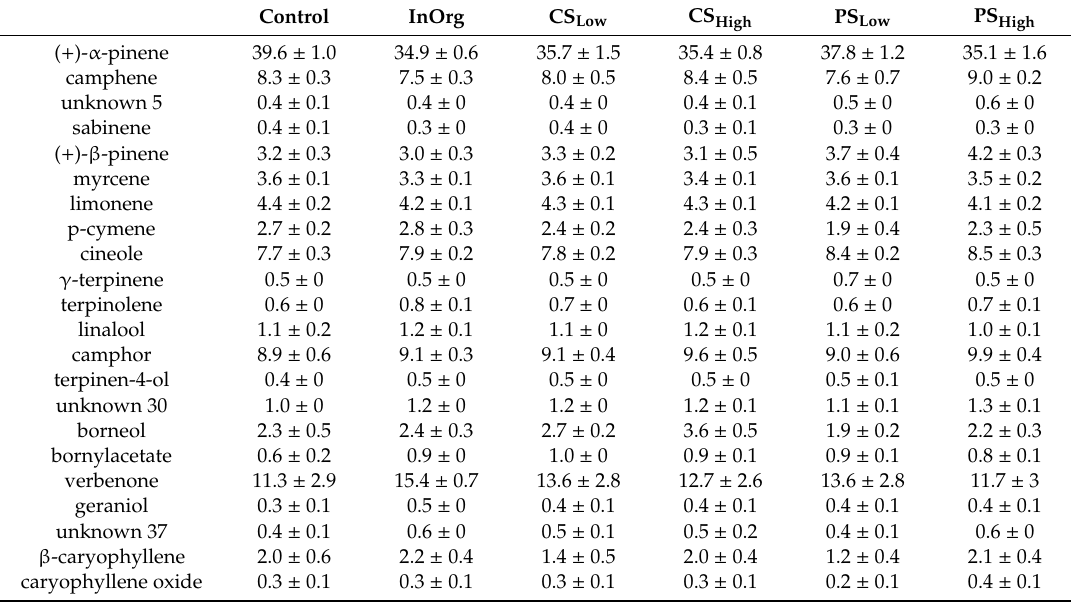
Table 2. Relative amounts of terpenoids (% of the total) in Rosmarinus o ffi cinalis leaves for the fertilization treatments: Control, InOrg, CS Low , CS High , PS Low and PS High . Data reported as mean values ± standard errors ( n = 3) are